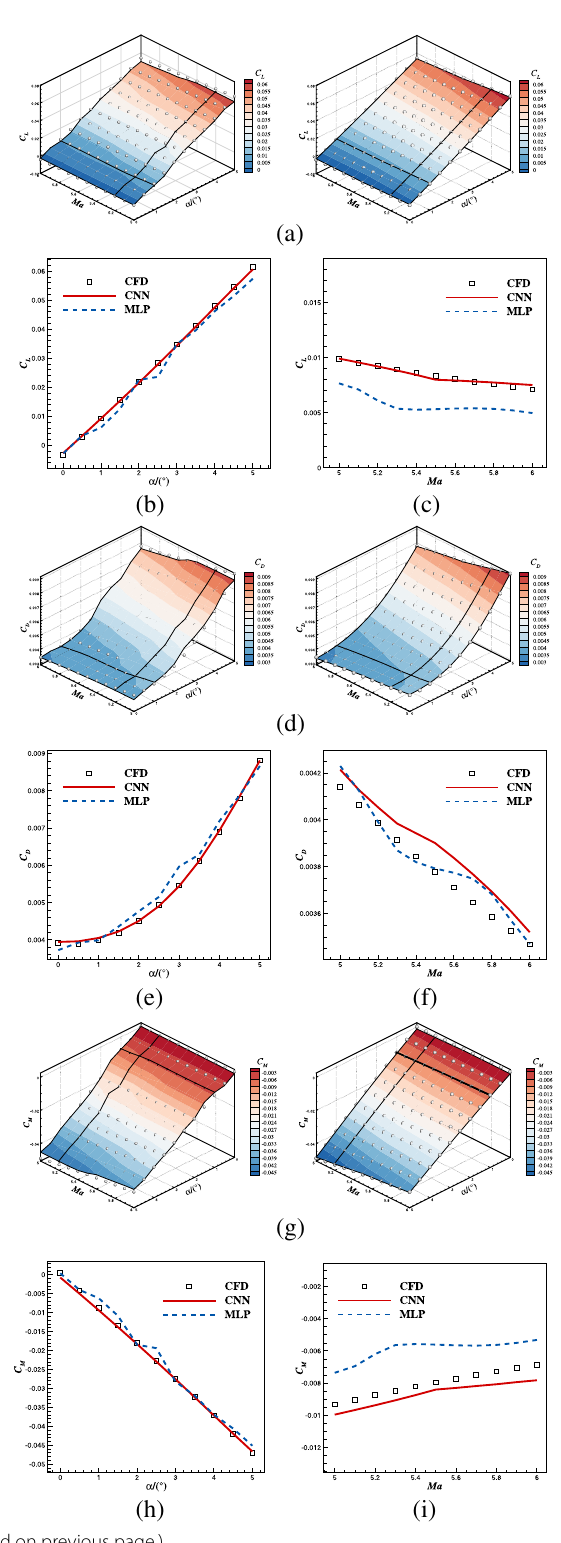
Fig. 23 (See legend on previous